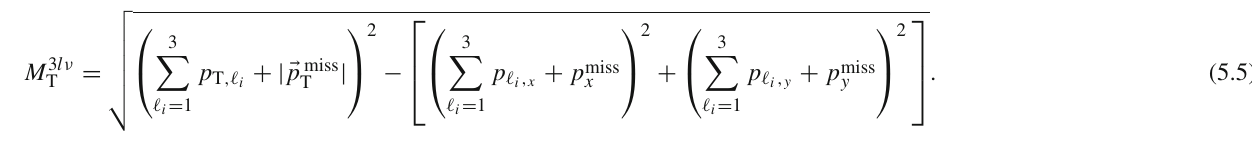
same order as the NLO EW corrections to the integrated cross section. The NLO QCD corrections are positive, slightly more pronounced in the central region and again of the same order as the NLO QCD corrections to the integrated cross section. ( NLO ) , defined in Eq. (5.2), are shown in The ratios R LO lin ( quad ) Figs. 13 and 14 as a function of the Z-boson transverse momentum ( p T ,μ + μ − ) and as a function of the WZ trans- ). As in Figs. 7 and 8 we use the values verse mass ( M 3 l ν T in Eq. (3.11) for the Wilson coefficients, and only one Wil-